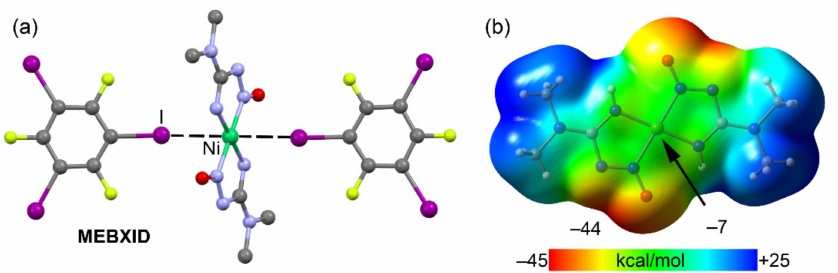
Figure 18. ( a ) Ball-and-stick representation of the X-ray solid-state structure of MEBXID in which the HaBs are indicated as dashed lines; ( b ) MEP surface of Ni(nitroguanidate) 2 using the 0.001 a.u. isosurface (energies in kcal/mol). H atoms are omitted for